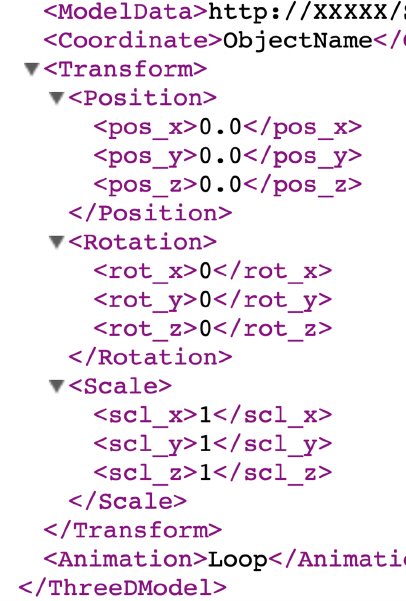
Figure 23. Description example of 3D Model